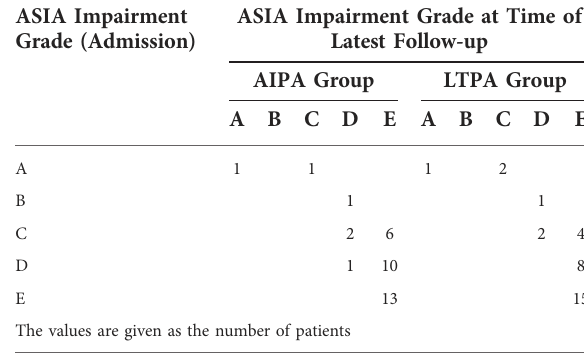
TABLE 4 Neurological status of patients in AIPA and LTPA